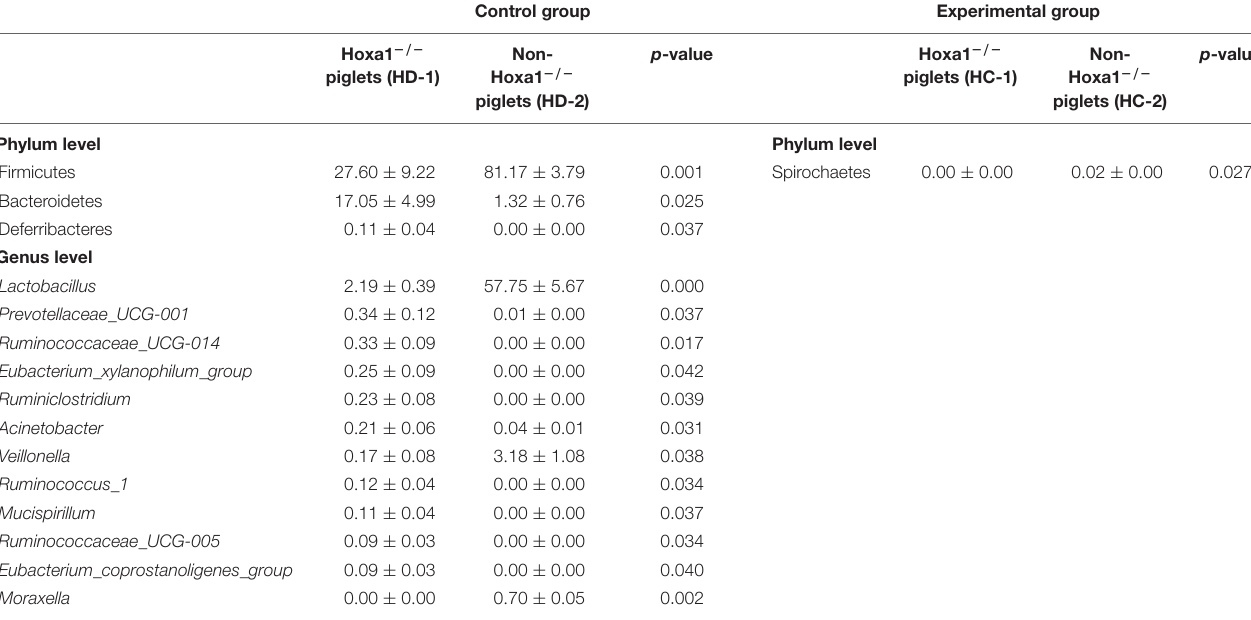
TABLE 5 | The differential ileal bacterial community of newborn piglets between different genotypes within the same treatment group (%). Control